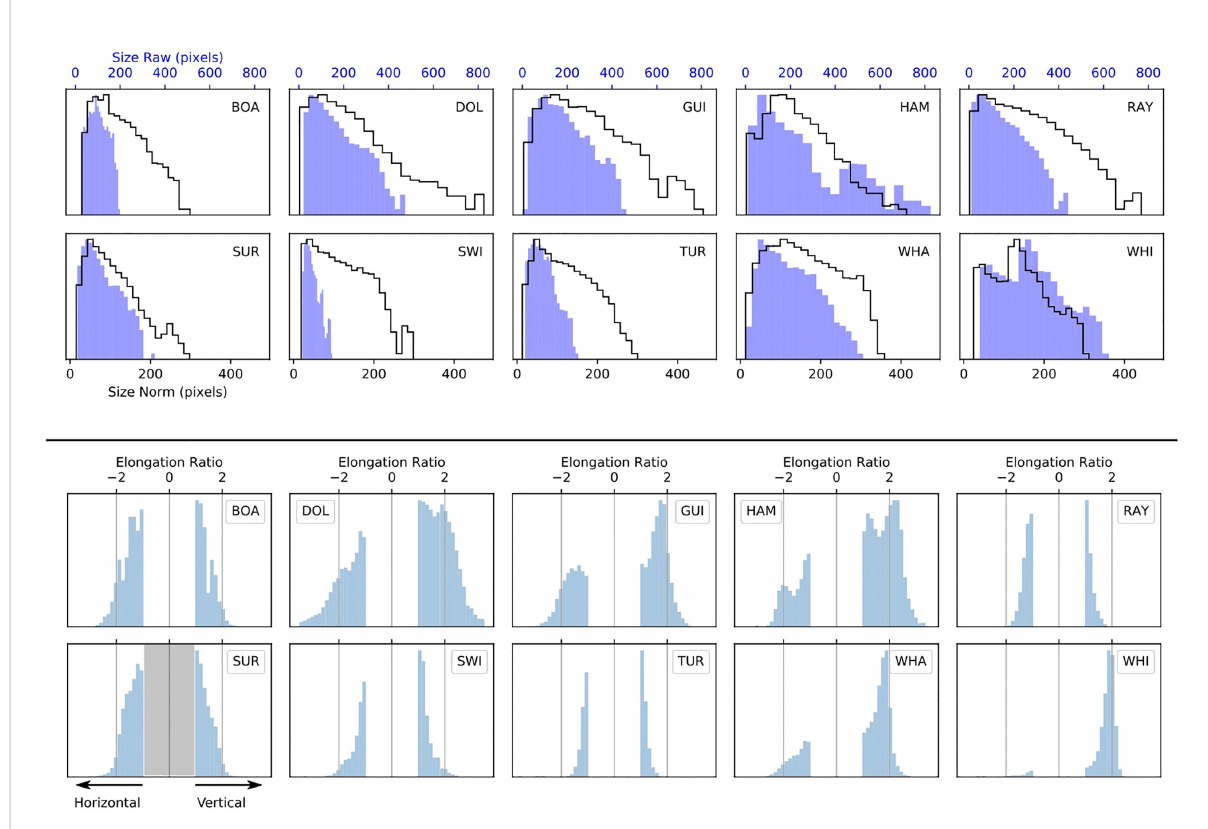
FIGURE 6 Top: Histograms showing the distributions of bounding box size for each class of object on a log scale (y-axis) to emphasize the low-level structure. Here ‘ size ’ is the geometric average of the side-lengths √ height × width. In each panel the blue- fi lled histogram shows the distribution before normalisation, while the black outline histogram shows the distribution after applying the scaling and cropping scheme described in § 3.3.2. This of fl ine augmentation technique attempts to normalise the size distributions between classes by cutting out a zoomed section of image, but this method cannot be used when objects occupy most of the frame, as is the case for signi fi cant numbers of hammerhead and white shark images (labelled HAM and WHI above). Note the different x-axis scales for the ‘ before ’ and ‘ after ’ distributions, re fl ecting the down-sizing of training images to 1080p resolution. Bottom: Distributions of bounding box elongation ratio for each class in the training data after augmentation. Vertically elongated boxes have positive ratios (= height/width) and horizontally elongated boxes have negative ratios (= − 1×width/height). Note that boxes around white sharks (WHI) are almost all vertically elongated, indicating animals tracked from behind by the drone operator. There was limited scope to rotate these data because many animals occupied the full fi eld-of-view. Whaler sharks (WHA) and guitar fi sh (GUI) also show similar issues, but to a less extreme degree. Turtles (TUR) and rays (RAY) tend to have ratios closer to unity, indicating more square